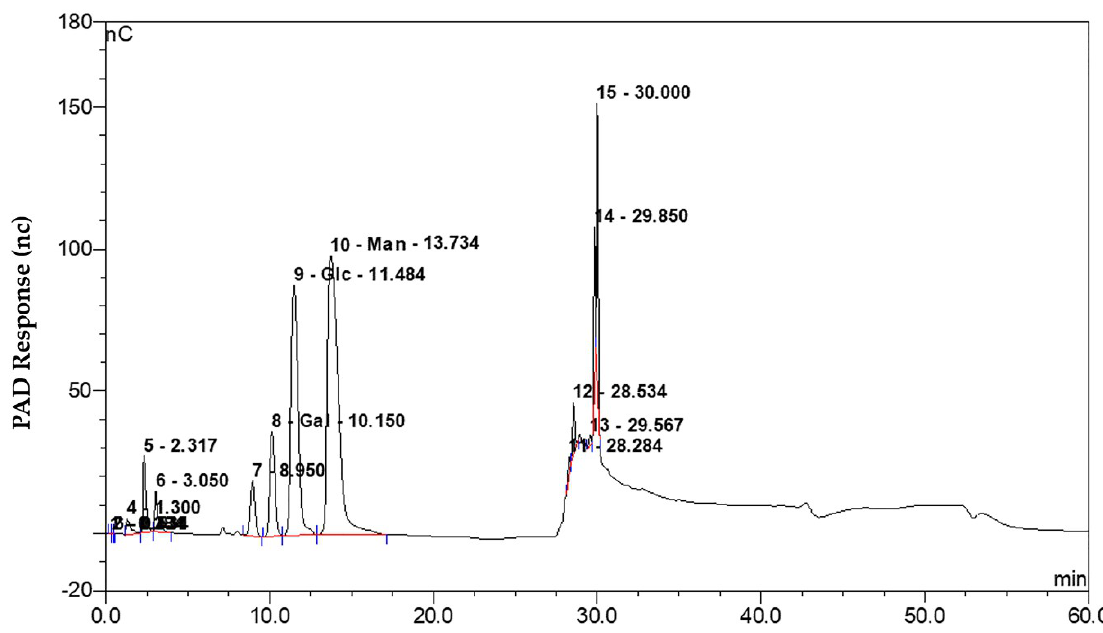
Figure 7. High performance anion exchange chromatography analysis of the monosaccharide composition of exopolysaccharides formed by wild type FZB42 cells. Peaks 8, 9, and 10 correspond to, respectively, galactose, glucose, and mannose. Red line represented the base line. Additional signals occurring between 28 and 32 min were system peaks.